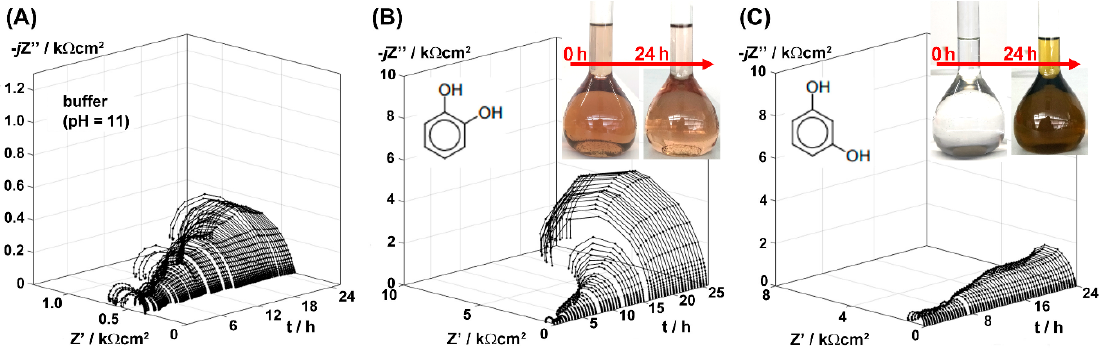
Figure 7. The g-DEIS impedance graphs of aluminum alloy 5754 in Nyquist projection during 24 h exposure in ( A ) bicarbonate buffer (pH = 11); and with the addition of ( B ) 10 mM catechol and ( C ) 10 mM resorcinol.